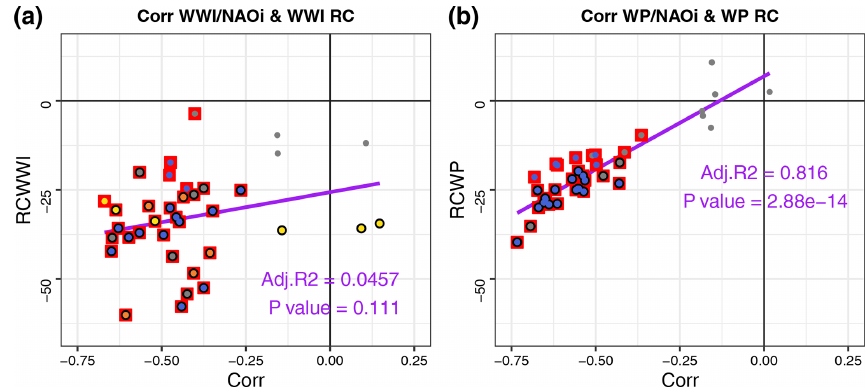
Figure 5. Correlations of (a) WWI and (b) WP with NAOi ( x axis) in relation to the RC in each variable ( y axis). The red squares show significant correlation values; the black circles show significant RC values for each variable; and the coloured circles show the BP detected, which can be 1978 (yellow), 1979 (blue), 1980 (orange), or other (grey). The purple line and text show the linear regression coefficients.